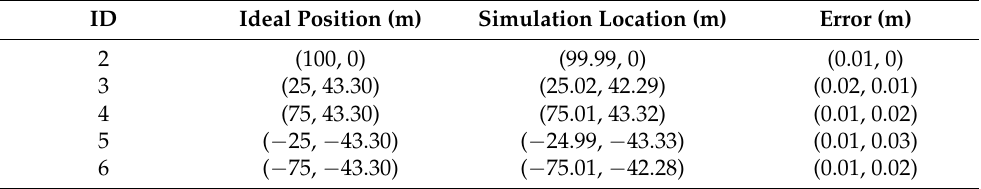
Table 1. Comparison of base station positioning coordinates and ideal position coordinates.